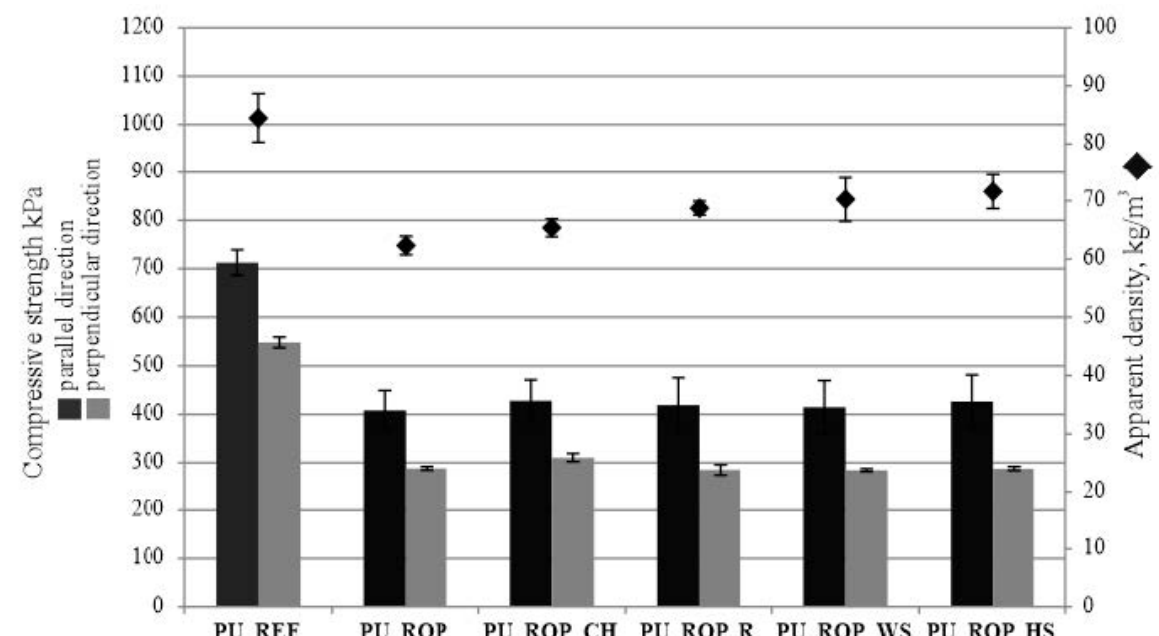
Figure 15. The compressive strength and apparent density of the